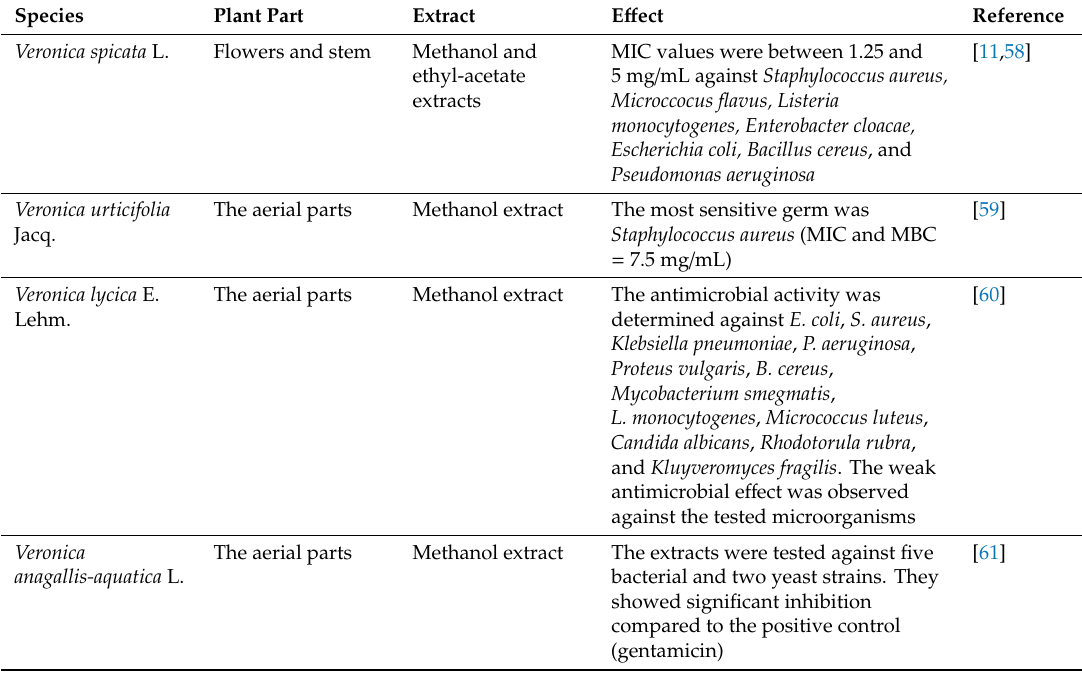
Table 3. Summary of the antimicrobial activity of di ff erent Veronica species. MIC—minimum inhibitory concentration; MBC—minimum bactericidal